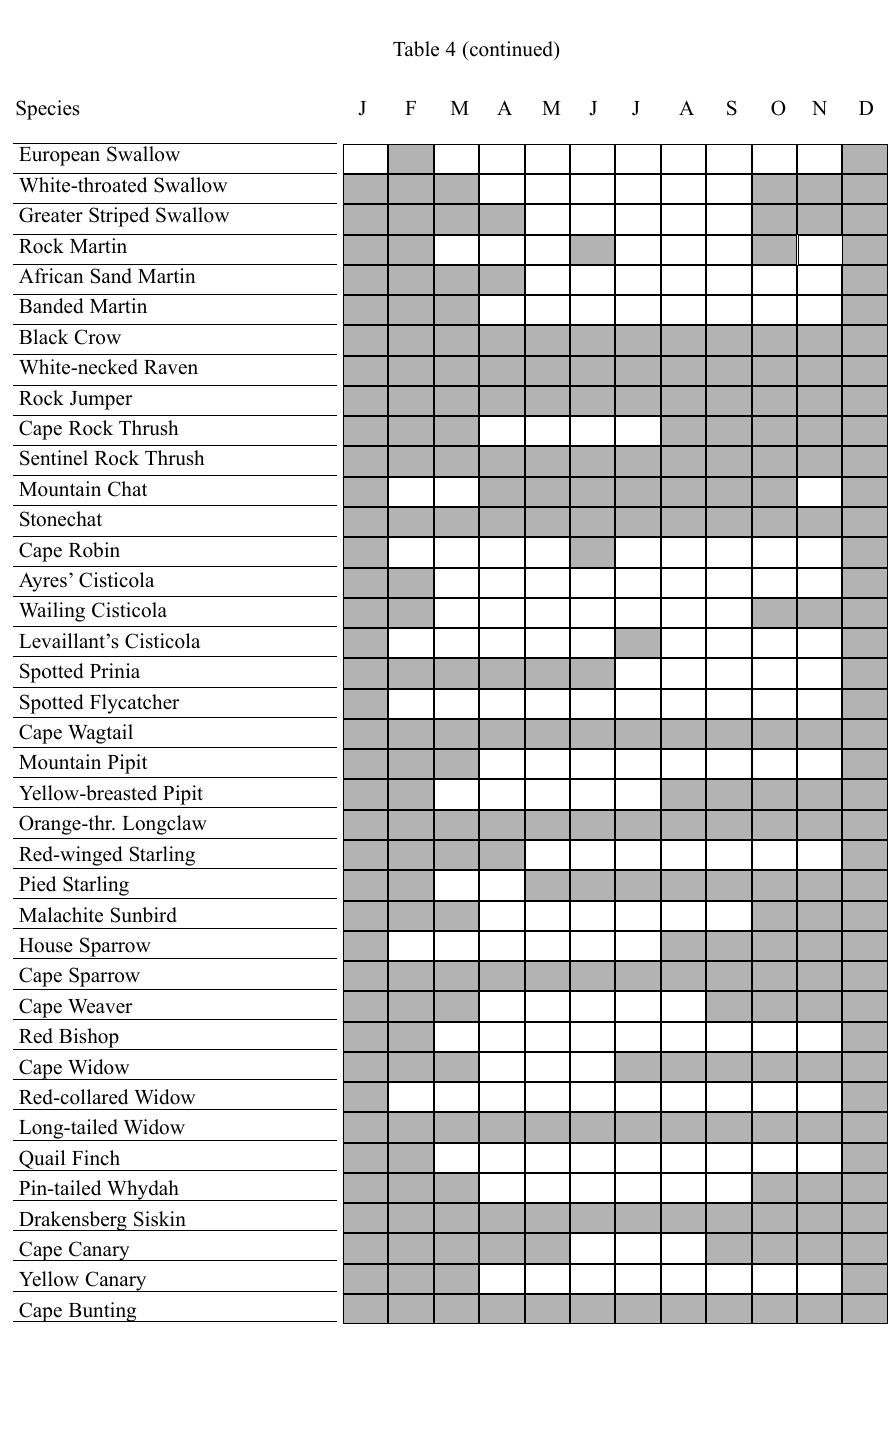
European Swallow White-throated Swallow Greater Striped Swallow Rock Martin African Sand Martin Banded Martin Black Crow White-necked Raven Rock Jumper Cape Rock Thrush Sentinel Rock Thrush Mountain Chat Stonechat Cape Robin Ayres’ Cisticola Wailing Cisticola Levaillant’s Cisticola Spotted Prinia Spotted Flycatcher Cape Wagtail Mountain Pipit Yellow-breasted Pipit Orange-thr. Longclaw Red-winged Starling Pied Starling Malachite Sunbird House Sparrow Cape Sparrow Cape Weaver Red Bishop Cape Widow Red-collared Widow Long-tailed Widow Quail Finch Pin-tailed Whydah Drakensberg Siskin Cape Canary Yellow Canary